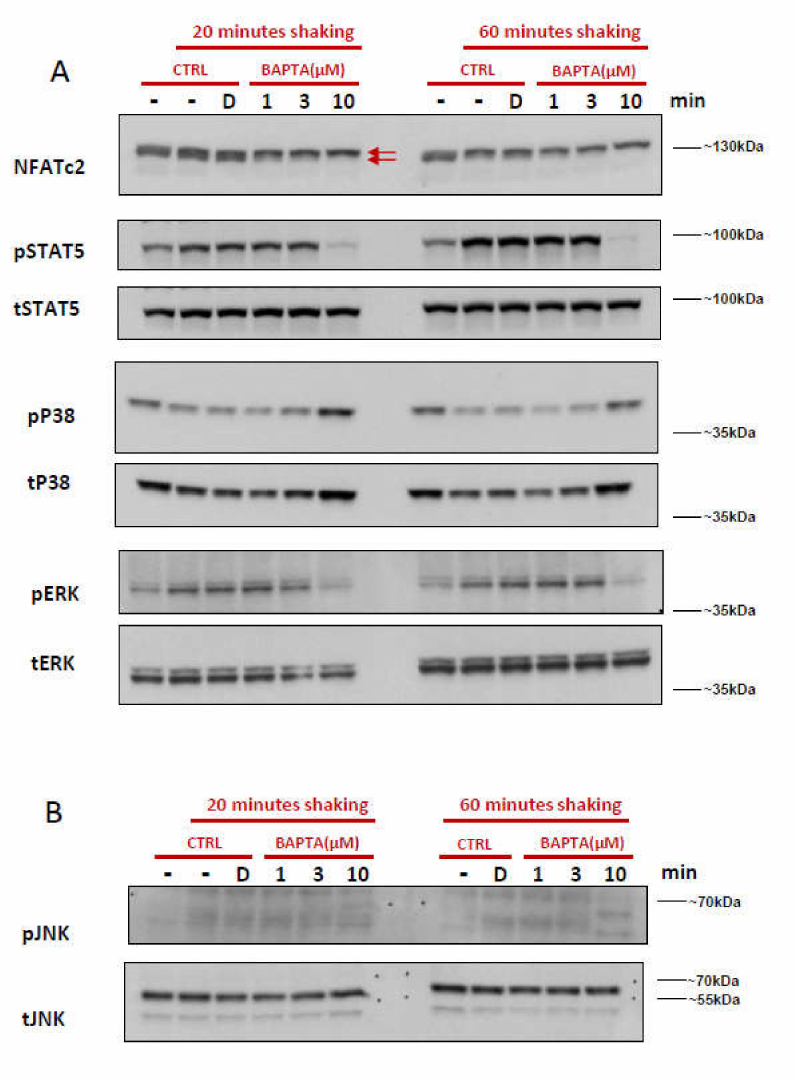
Figure 3. Intracellular Ca 2+ chelation prevents shear-induced signaling pathways. Cultured ery- throblasts were preincubated for 10 min under static conditions, and subsequently orbitally shaken at 300 rpm for 20 or 60 min (first lane = Time 0). These cultures were left untreated (CTRL, -), treated with solvent DMSO (CTRL, D), or pre-incubated with 1, 3, and 10 µ M of the Ca 2+ chelator BAPTA-AM (BAPTA( µ M), 1, 3, 10). Total protein lysates were subjected to SDS-polyacrylamide gel electrophoresis and western blotting. ( A ) Blots were stained with anti-NFATc2, anti-p-STAT5 and total-STAT5, anti-p-ERK1/2 (Thr202/Tyr204), anti-Total-ERK1/2, anti-p-P38 (Thr180/Tyr182), anti-total p38. ( B ) Blots were stained with anti-pJNK (Thr183/Tyr185) and